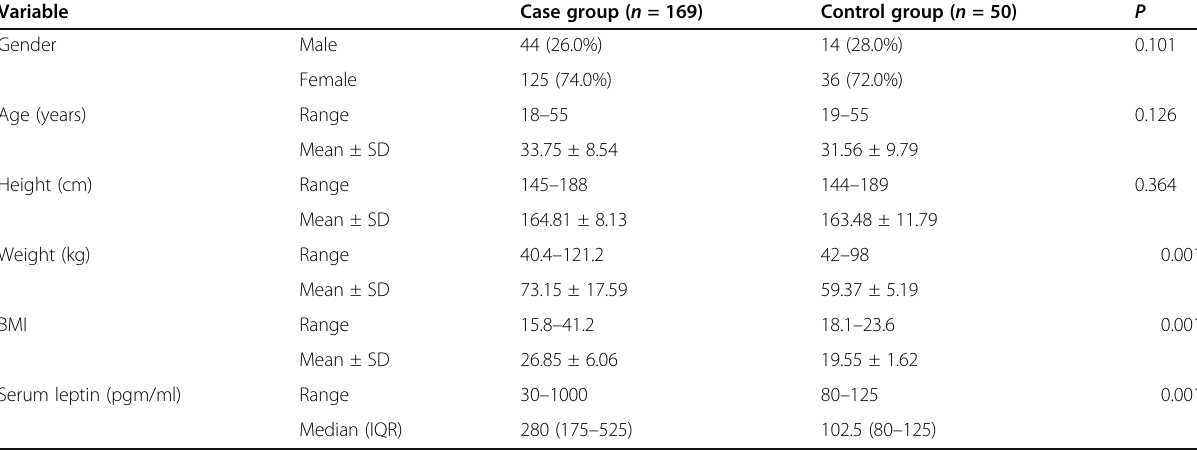
Table 1 Comparison between patients and controls as regards demographic data, height, weight, and BMI and serum leptin level Variable Case group ( n = 169) Control group ( n =